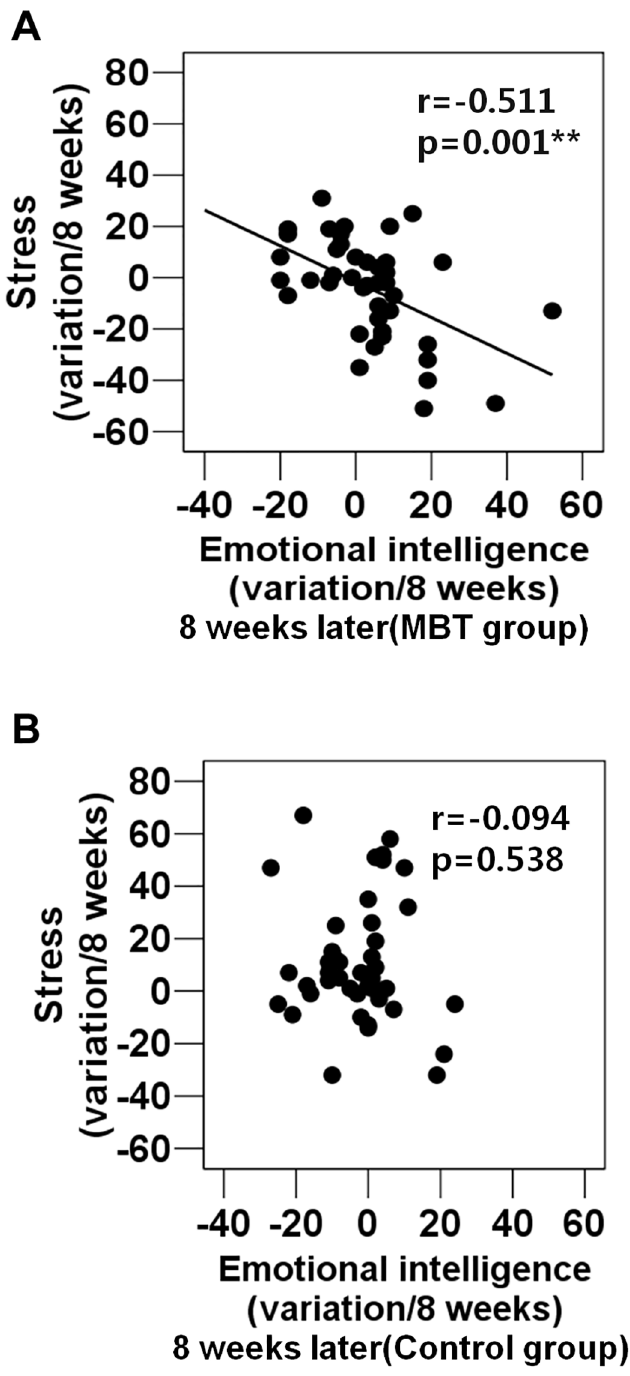
Fig 5. Correlations between emotional intelligence (8-week variations) and perceived stress (8-week variations) in each group. (A) A correlation between emotional intelligence (8-week variations) and perceived stress (8-week variations) in the MBT group. (B) A correlation between emotional intelligence and perceived stress (8-week variations) in the control group.